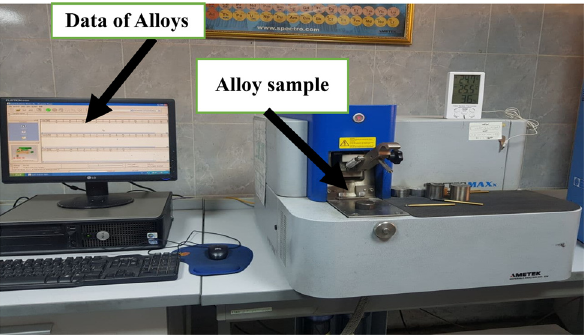
Figure 2: Chemical composition analysis ( spectrophotometer )